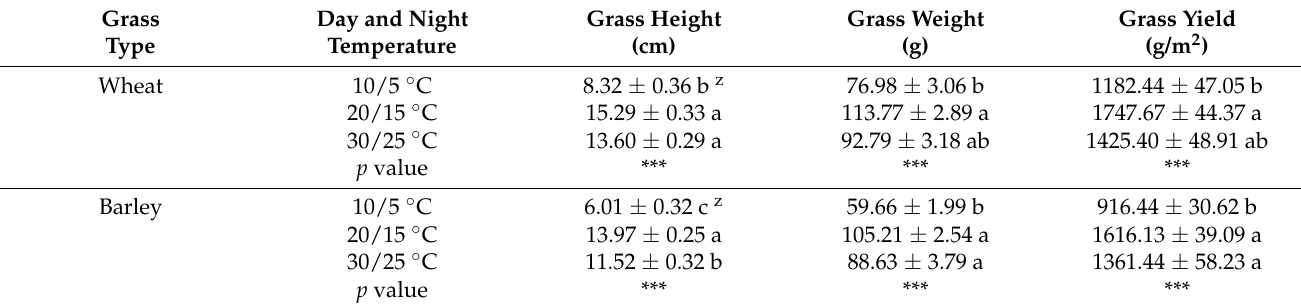
Table 1. Growth parameters of young wheat and barley grasses treated with different day and night temperatures. Grass Type